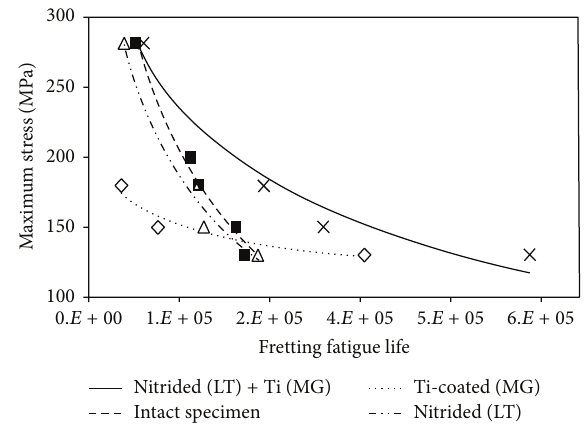
Figure 21: S-N curves for the duplex surface treatment, (Ni (LT) + Ti (MG)) [22].